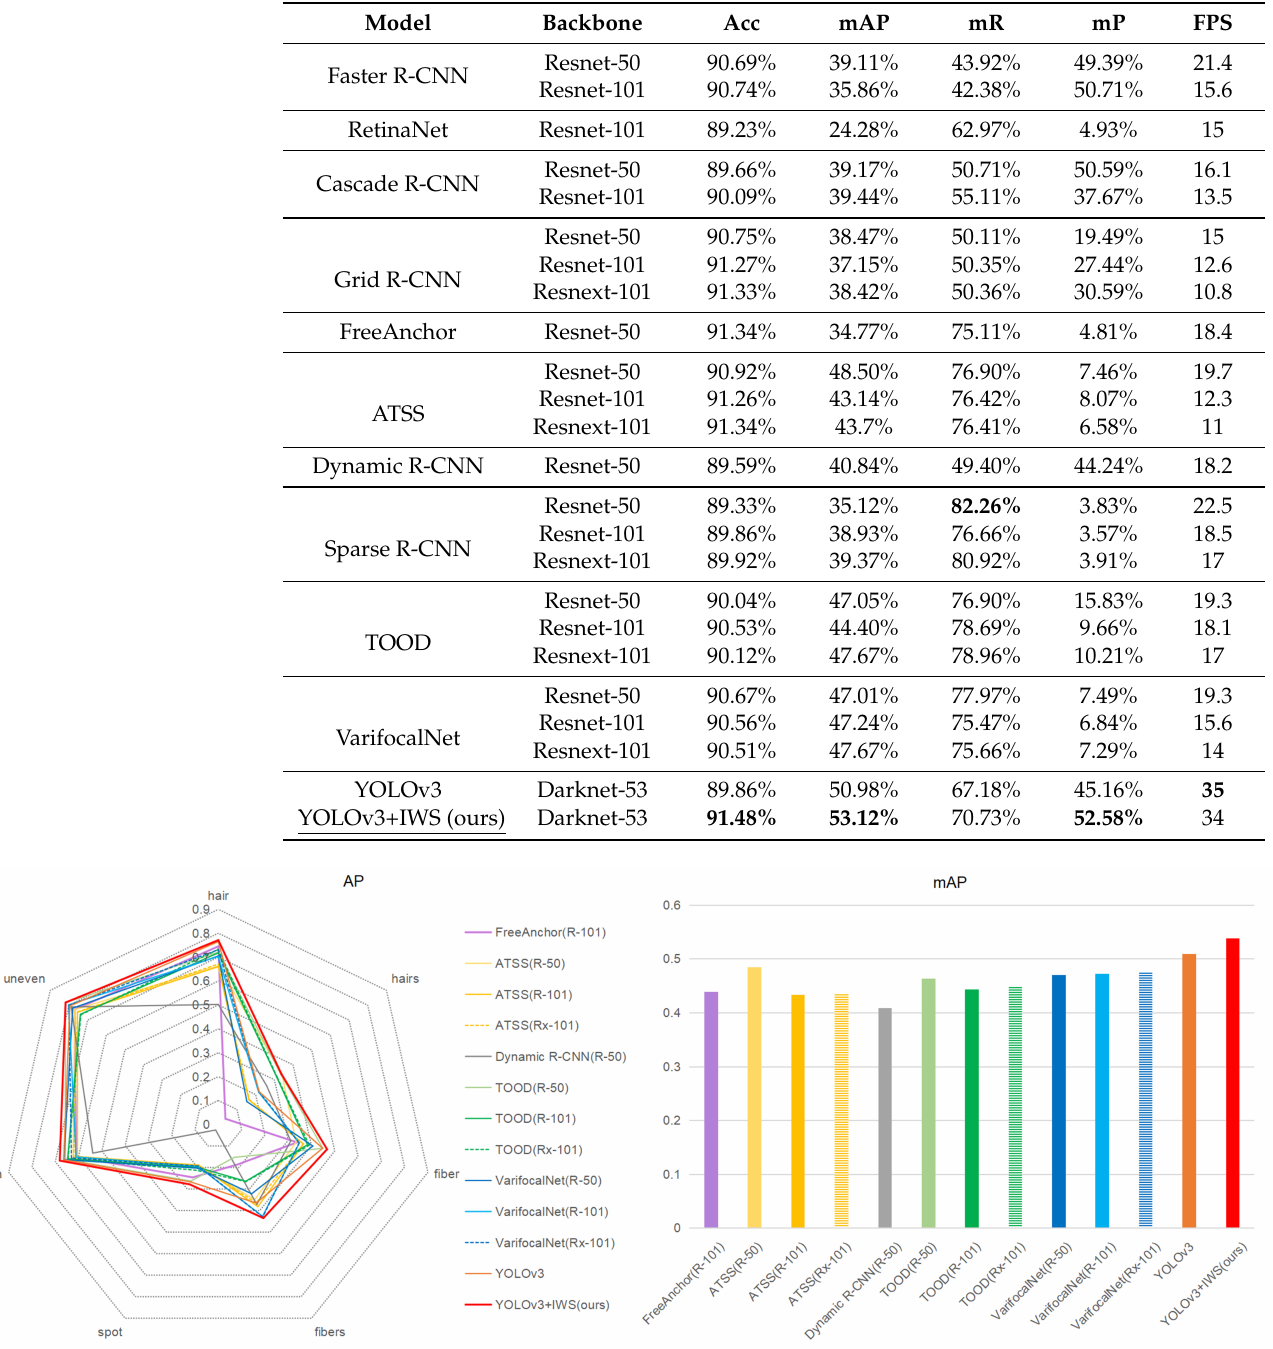
Table 4. Experimental results of IGBT_DF dataset.